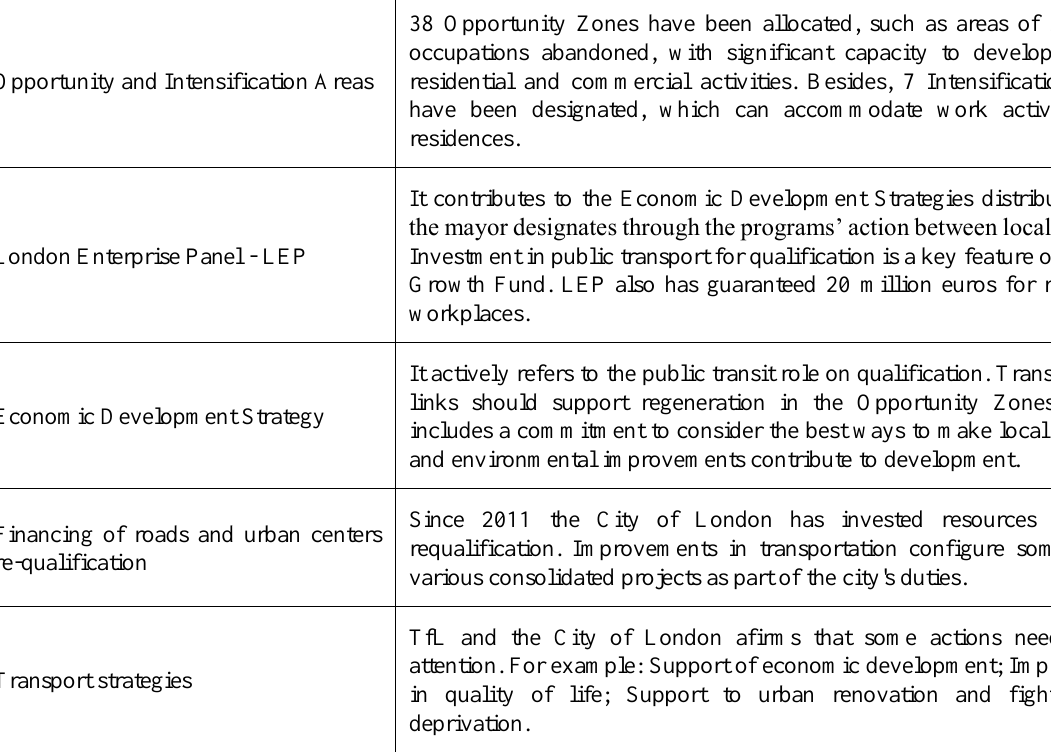
Table 2.London: Strategies and policies to support regeneration. Source: Authors, based on Mayor of London (2015).